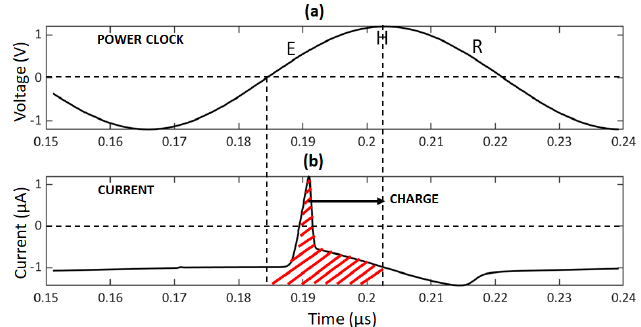
Figure 7. Proposed power sampling method in adiabatic SIMON core: ( a ) power-clock signal, ( b ) charge analysis with respect to the evaluate phase of the power-clock